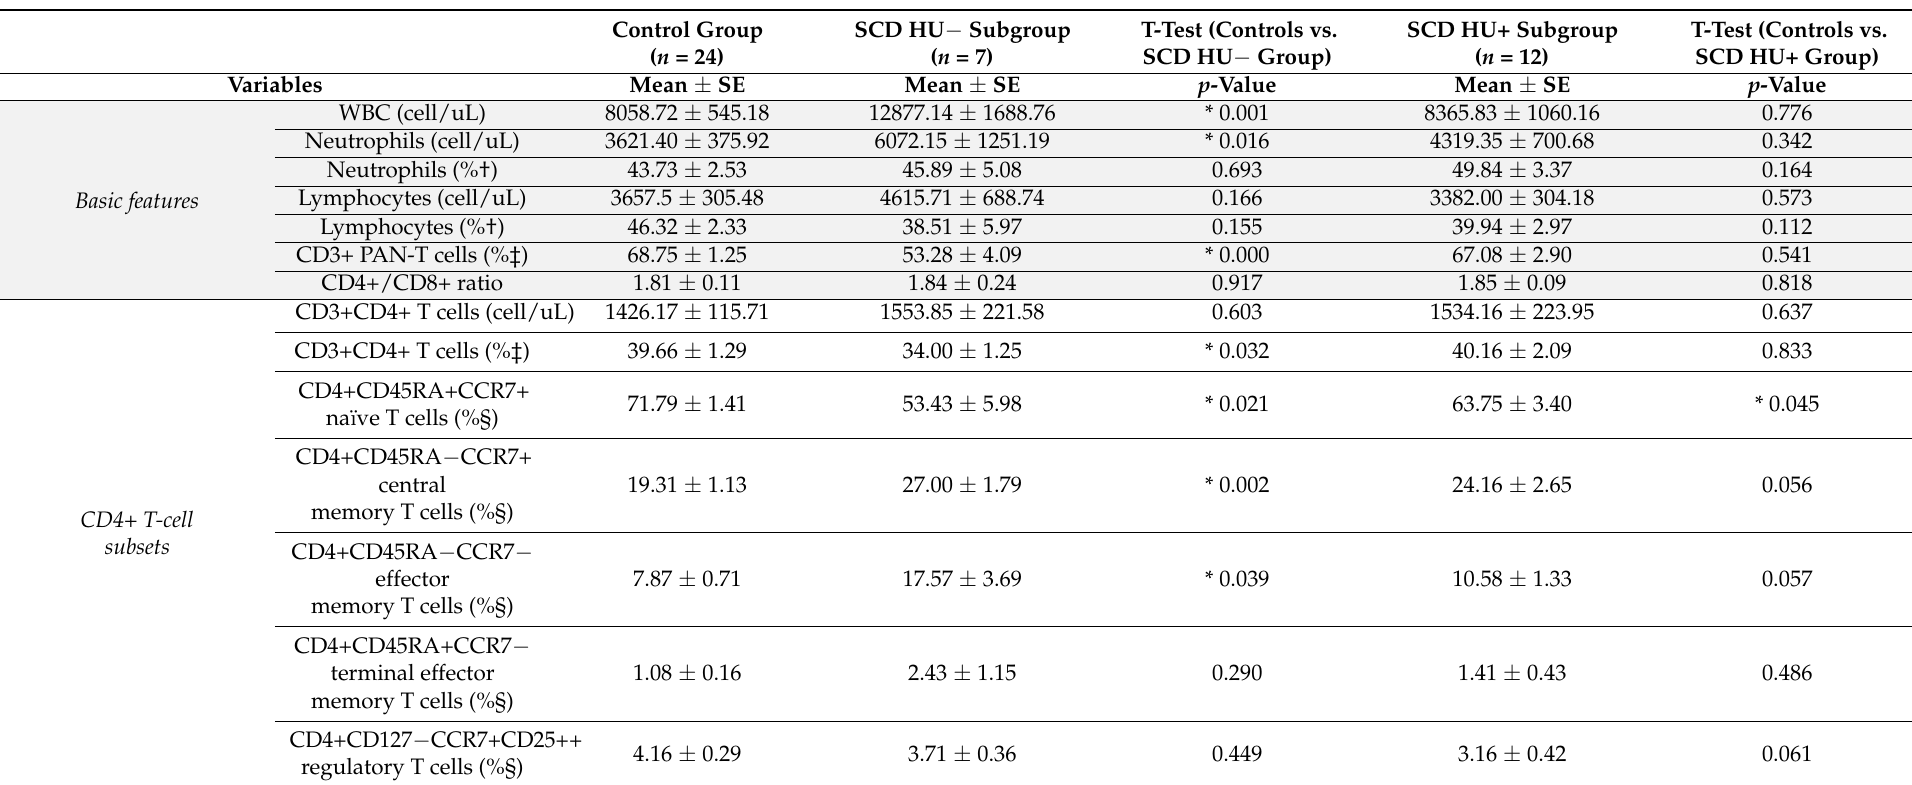
Table 3. Comparison of immunologic parameters between the SCD HU − , SCD HU+ and control groups (SE: standard